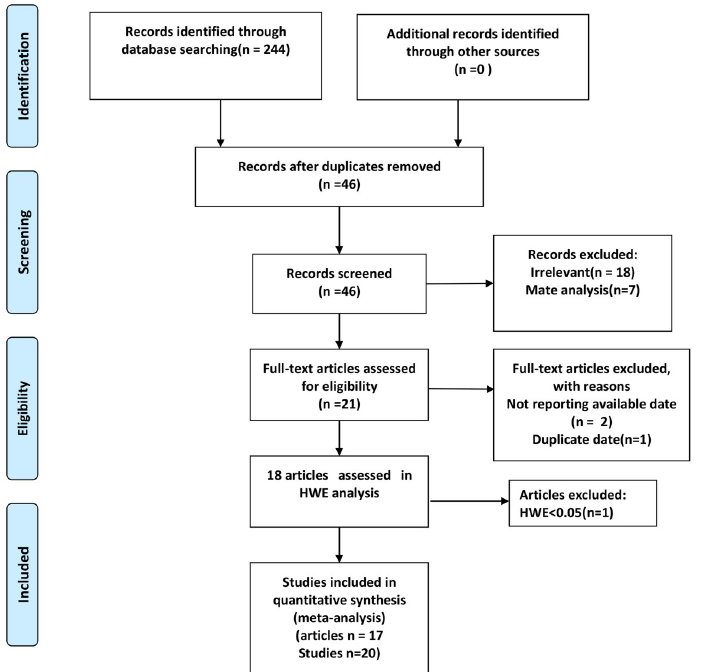
Fig 1. Flow diagram of study